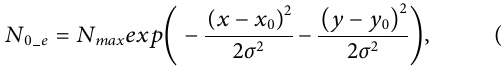
permittivity is ε p (cid:2) 7 . 5 + 0 . 43 x . Obviously, distribution as a function of length along x direction is of dielectric permittivity, the case in the condition of ε r (cid:2) 7 . 5 is studied as